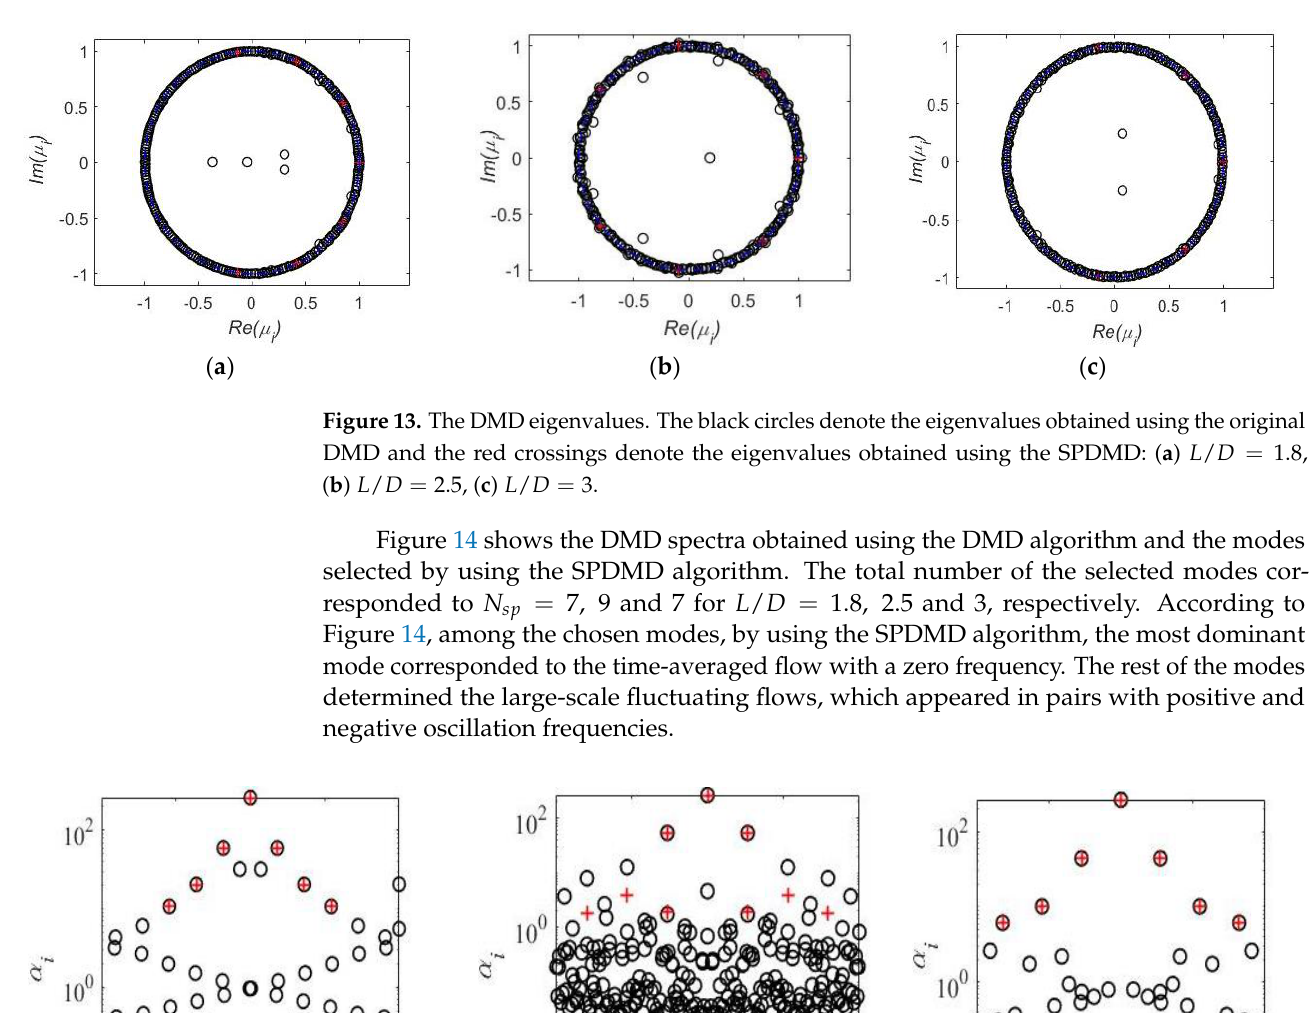
Table 5. Energy levels of the DMD modes and their respective contributions to the total energy.